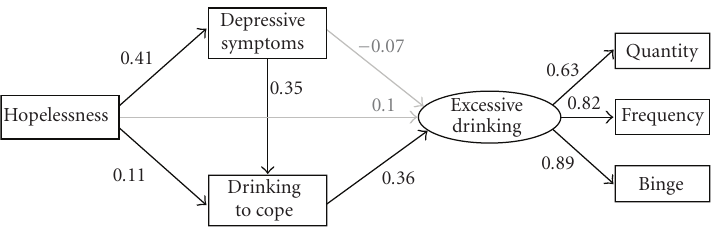
Figure 2: The hypothesized structural model. Rectangles represent manifest variables; ovals represent latent variables. Black arrows represent significant paths (i.e., P < .05). Grey arrows represent nonsignificant paths (i.e., P > .05). Path coe ffi cients are standardized. Quantity = drinking quantity; Frequency = drinking frequency; Binge = binge drinking. Table 2: Bootstrap analyses of hypothesized indirect e ff ects. Bootstrap